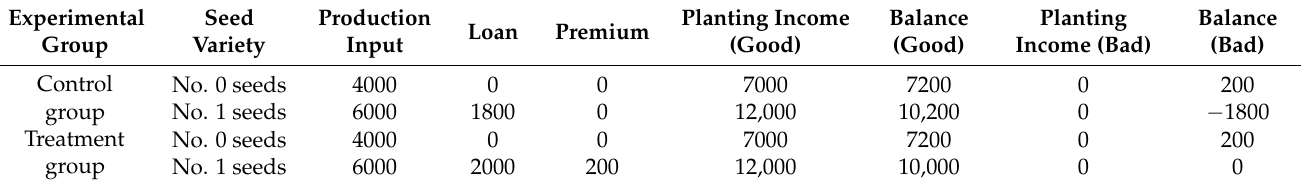
Table A4. Experimental parameter settings Comparison of traditional and innovative seeds (Unit: